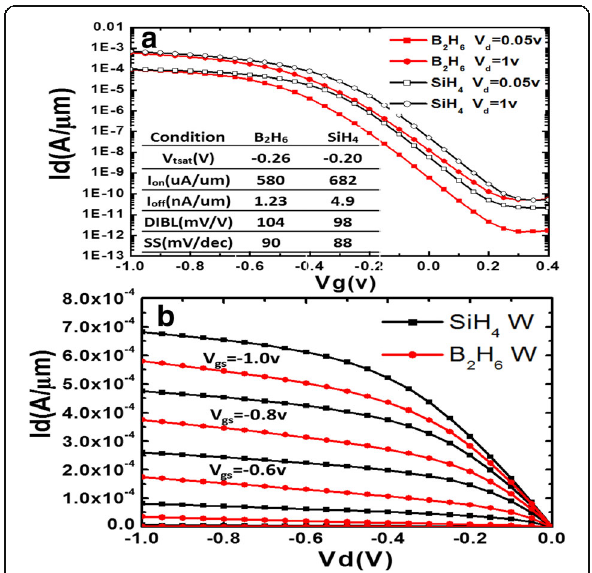
Fig. 5 a I d - V g and b I d - V d characteristics of fabricated pMOSFETs with ALD W as gate filling metal. Basic device parameters are extracted and shown in the inset of